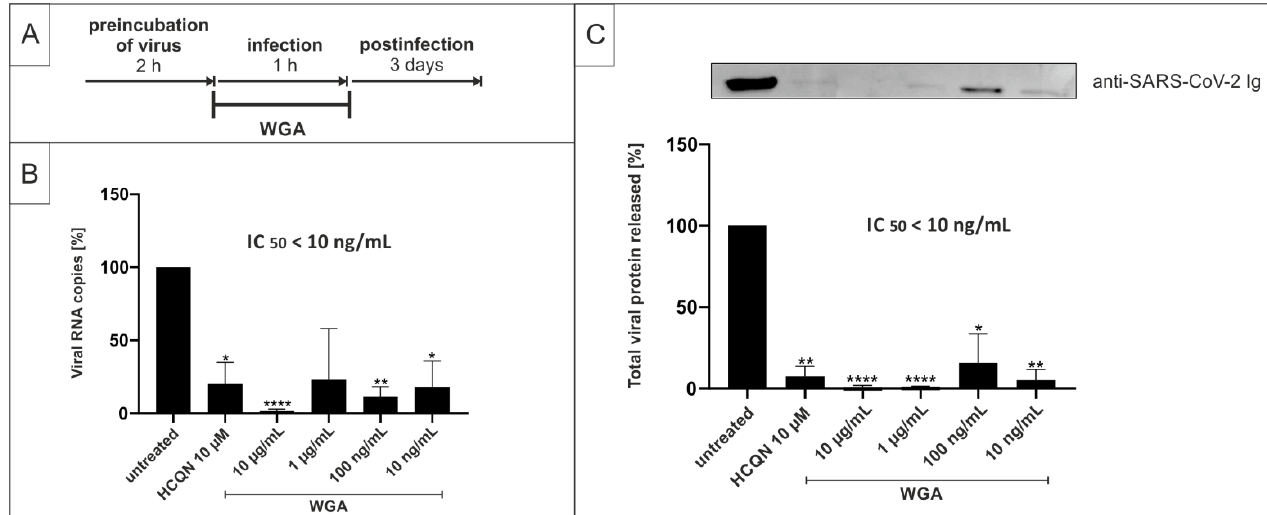
Figure 4. WGA inhibits SARS-CoV-2 replication in Vero B4 cells when present only during the time of infection. ( A ) Treatment scheme. TOA of WGA was only during infection of cells for 1 h. ( B ) qRT-PCR of cell culture supernatants after adding WGA to Vero B4 cells for 1 h during the time of infection and no further treatment afterwards. Analysis of three independent experiments. ( C ) Western blot analysis of released virions. Supernatants were harvested 3 dpi, virions were purified and analyzed by Western blot using anti-SARS-CoV-2 nucleoprotein antibody. Densitometric analysis of three independent experiments ± standard deviation using AIDA ® , one representative Western blot is shown. * p ≤ 0.05, ** p < 0.005 and **** p < 0.0001 using a one-sample t-test .